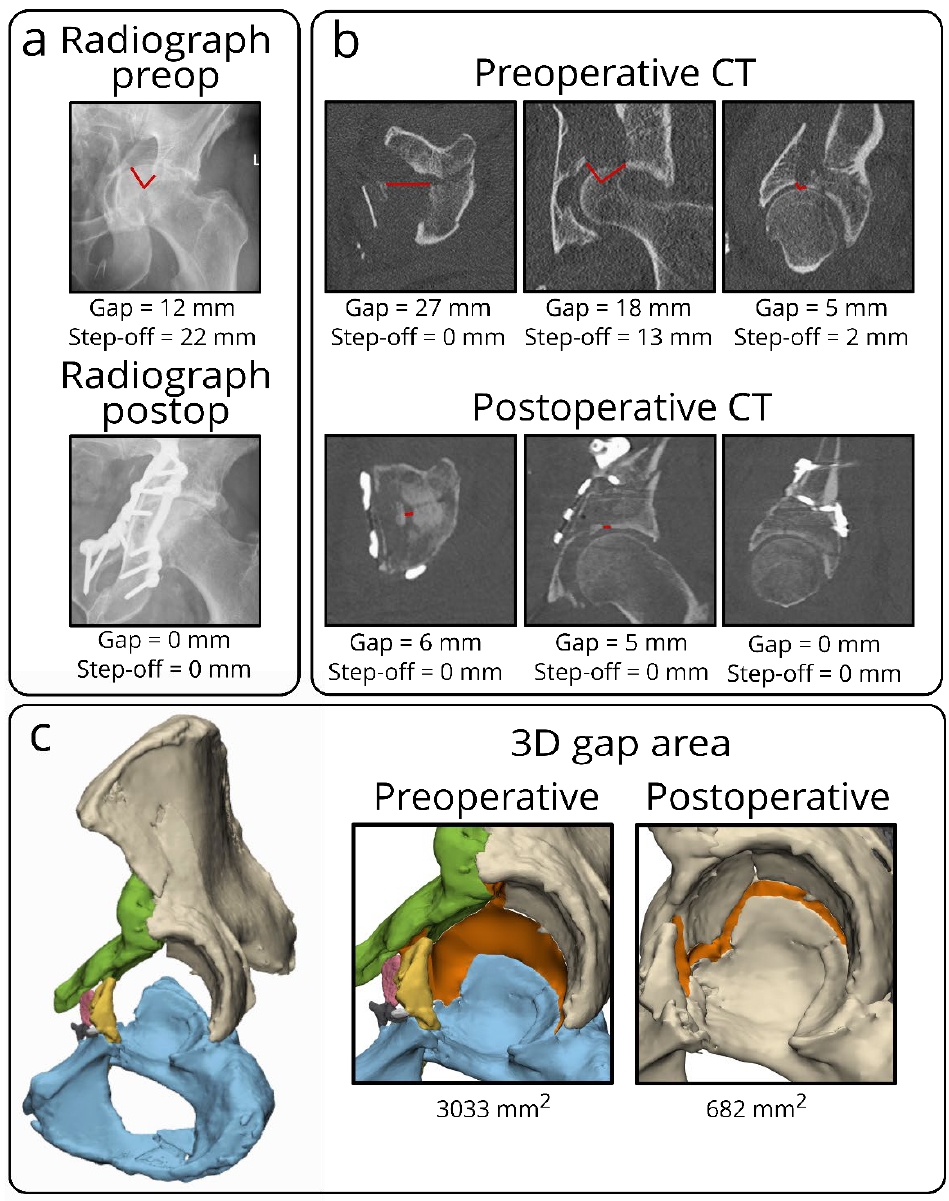
Figure 3. Case example of a both-column fracture in a 63-year-old male, showing the discrepancy in measuring initial and residual fracture displacement for acetabular fractures on different imaging modalities, including radiographs, CT scans, and 3D models. On radiographs ( a ), it is difficult to measure gaps and step-offs, especially on the postoperative radiograph, because the implant is partially obscuring the acetabulum. On the single CT slices ( b ), multiple gaps and step-offs (red lines) can be measured on different CT slices in several planes, indicating the subjective elements of these measurements. The 3D model ( c ) demonstrates the 3D gap area (in orange) representing the three-dimensional surface between all fracture fragments. This should be considered a single quantitative measure of the initial or residual fracture displacement in the entire acetabulum.